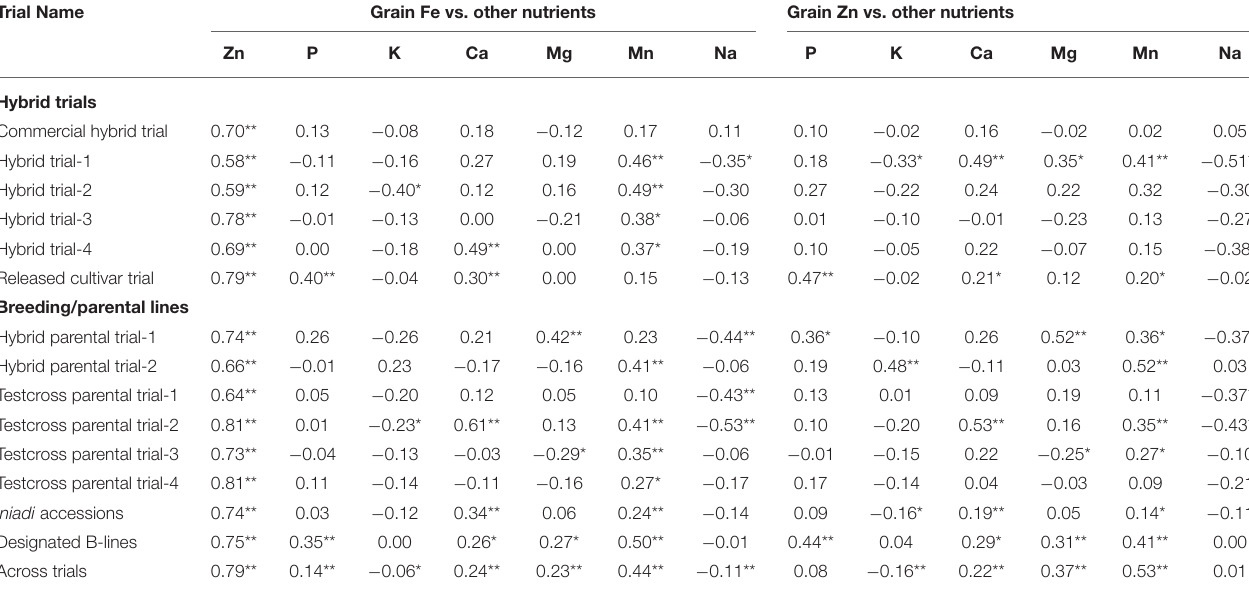
TABLE 4 | Correlation coefficient (r) of grain Fe and Zn density with other nutrients’ content in pearl millet breeding trials at ICRISAT, Hyderabad, India. Trial